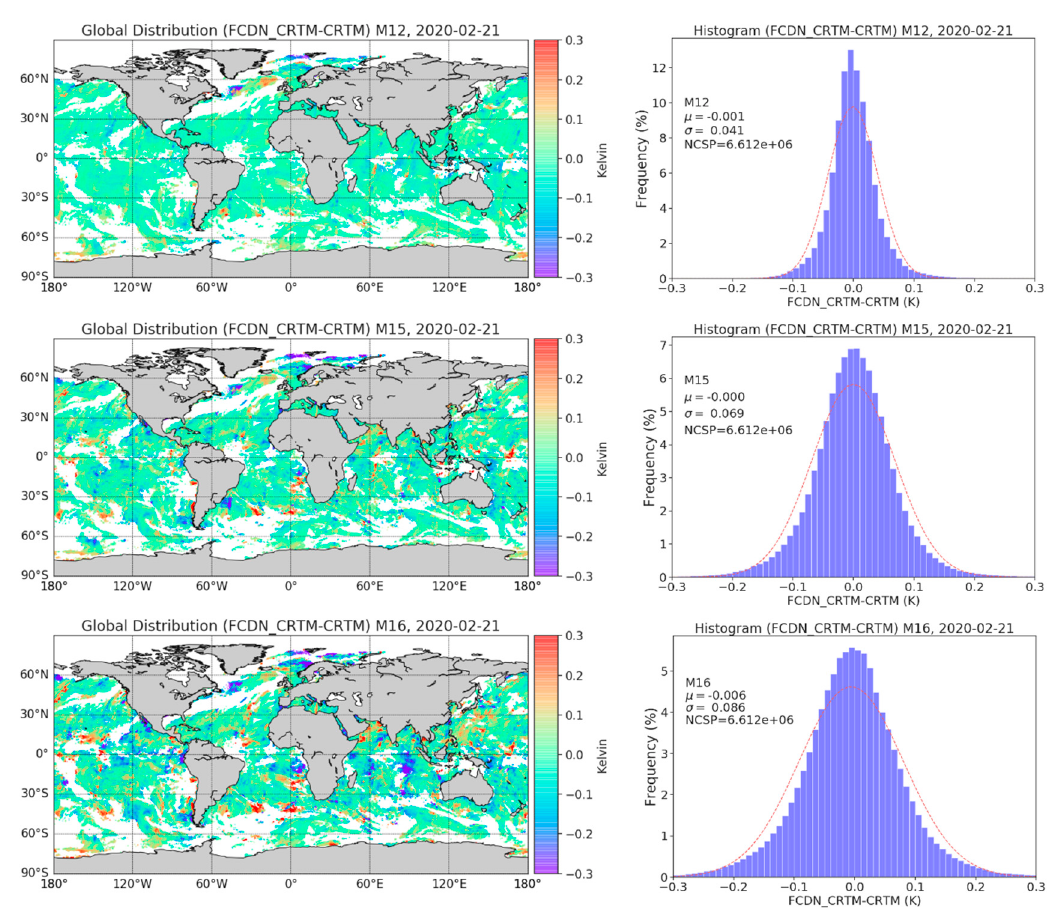
Figure 4. Global distributions ( left panel ) and histograms ( right panel ) of the differences between FCDN_CRTM predicted and CRTM in M12 ( upper ), M15 ( middle ) and M16 ( bottom ) on 02/21/2020.